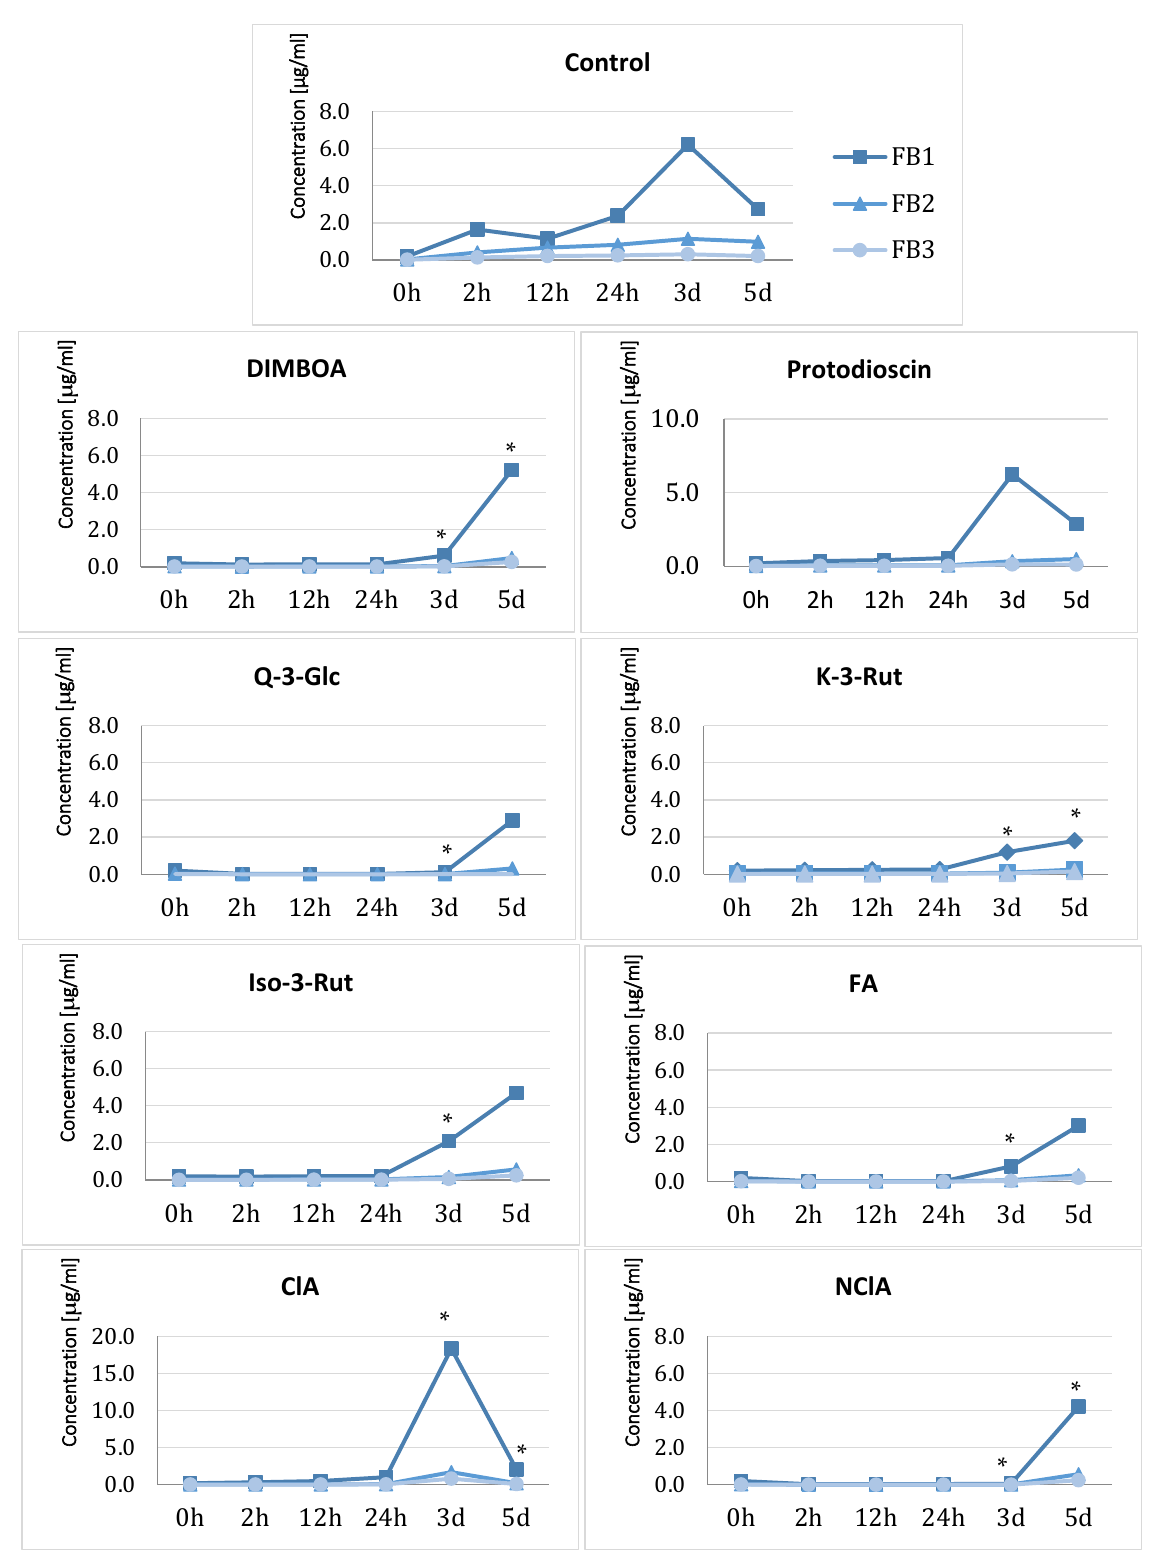
Figure 5. Changes in fumonisins concentrations in F. proliferatum KF 3360 cultures after the addition of plant metabolites: ■ — FB 1 , ▲ — FB 2 , ●— FB 3 . * differences statistically significant compared to control at p < 0.05. All analyses were done in triplicate. Detailed information along with SDs are included in Supplementary Table S3.